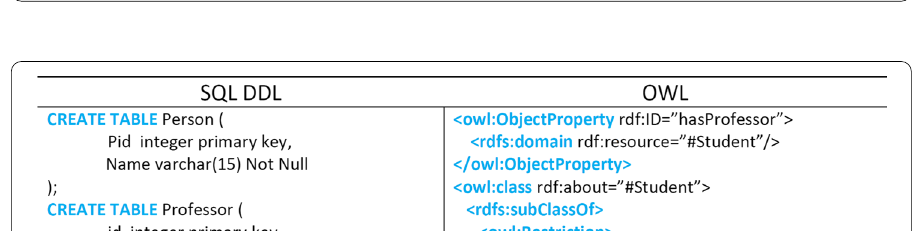
Fig. 4 Default Value constraint transformatio